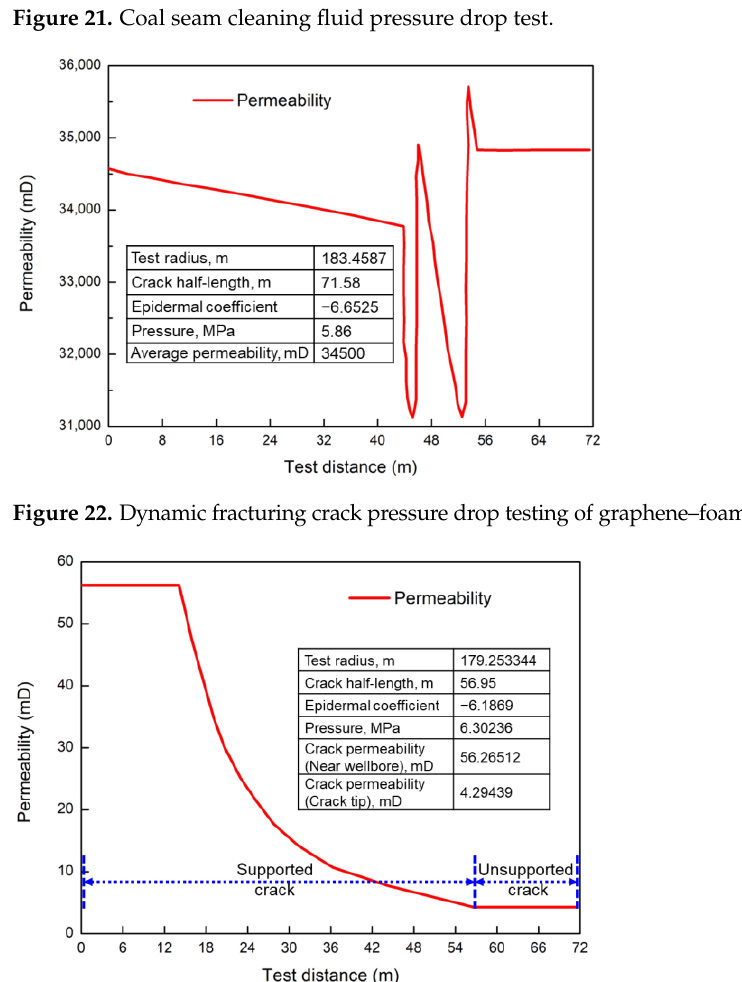
Figure 23. Static fracturing crack pressure drop testing after graphene – foam – cement slurry fractur- ing.